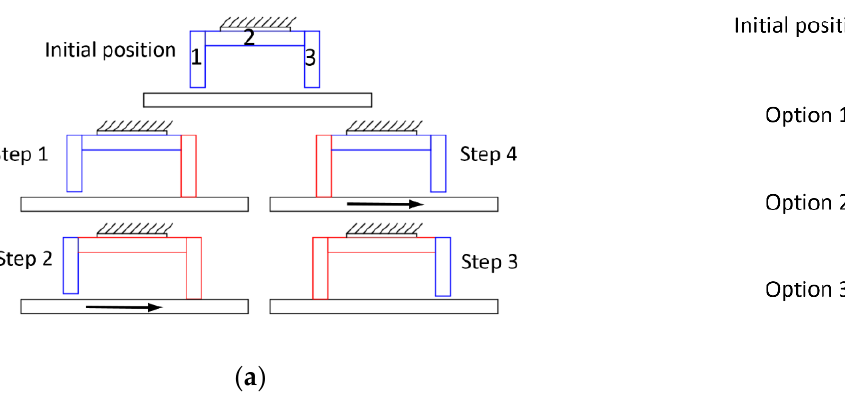
Figure 10. Schematic of the inchworm mechanism with stacked piezoelectric actuators. ( a ) Standard inchworm system with three piezoelectric stacks: stacks 1 and 3 are to create a clamping force, and stack 2 is to generate the movement. ( b ) Improvement of the inchworm concept with various clamping blocks and moving blocks integrating into the moving structure. Blue block: inactive piezoelectric (contract); red block: active piezoelectric (extend); black block: moving structure.